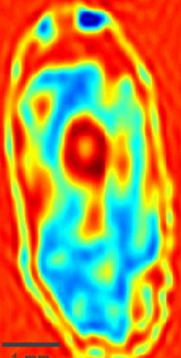
Figure 2. The terahertz image of the sample obtained by full scan